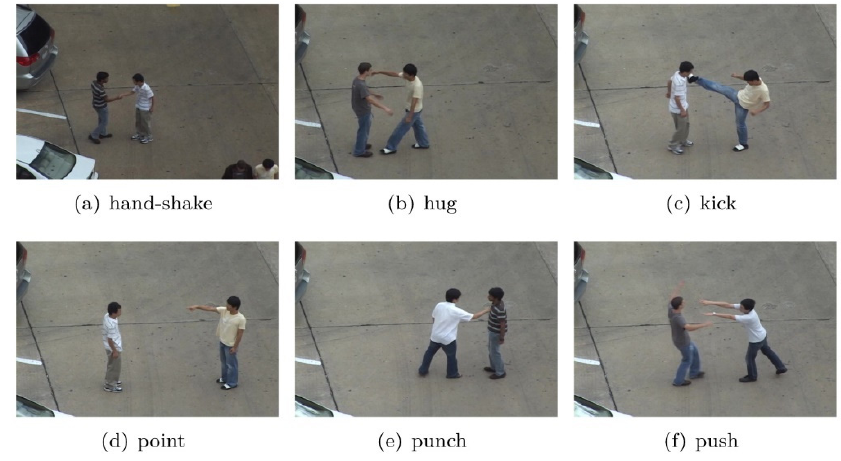
Figure 10. Example frames of each action of UT ‐ Interaction dataset.